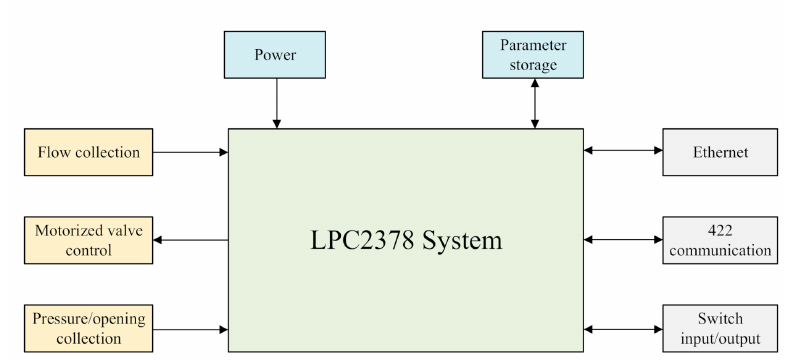
Figure 2. Hardware framework of